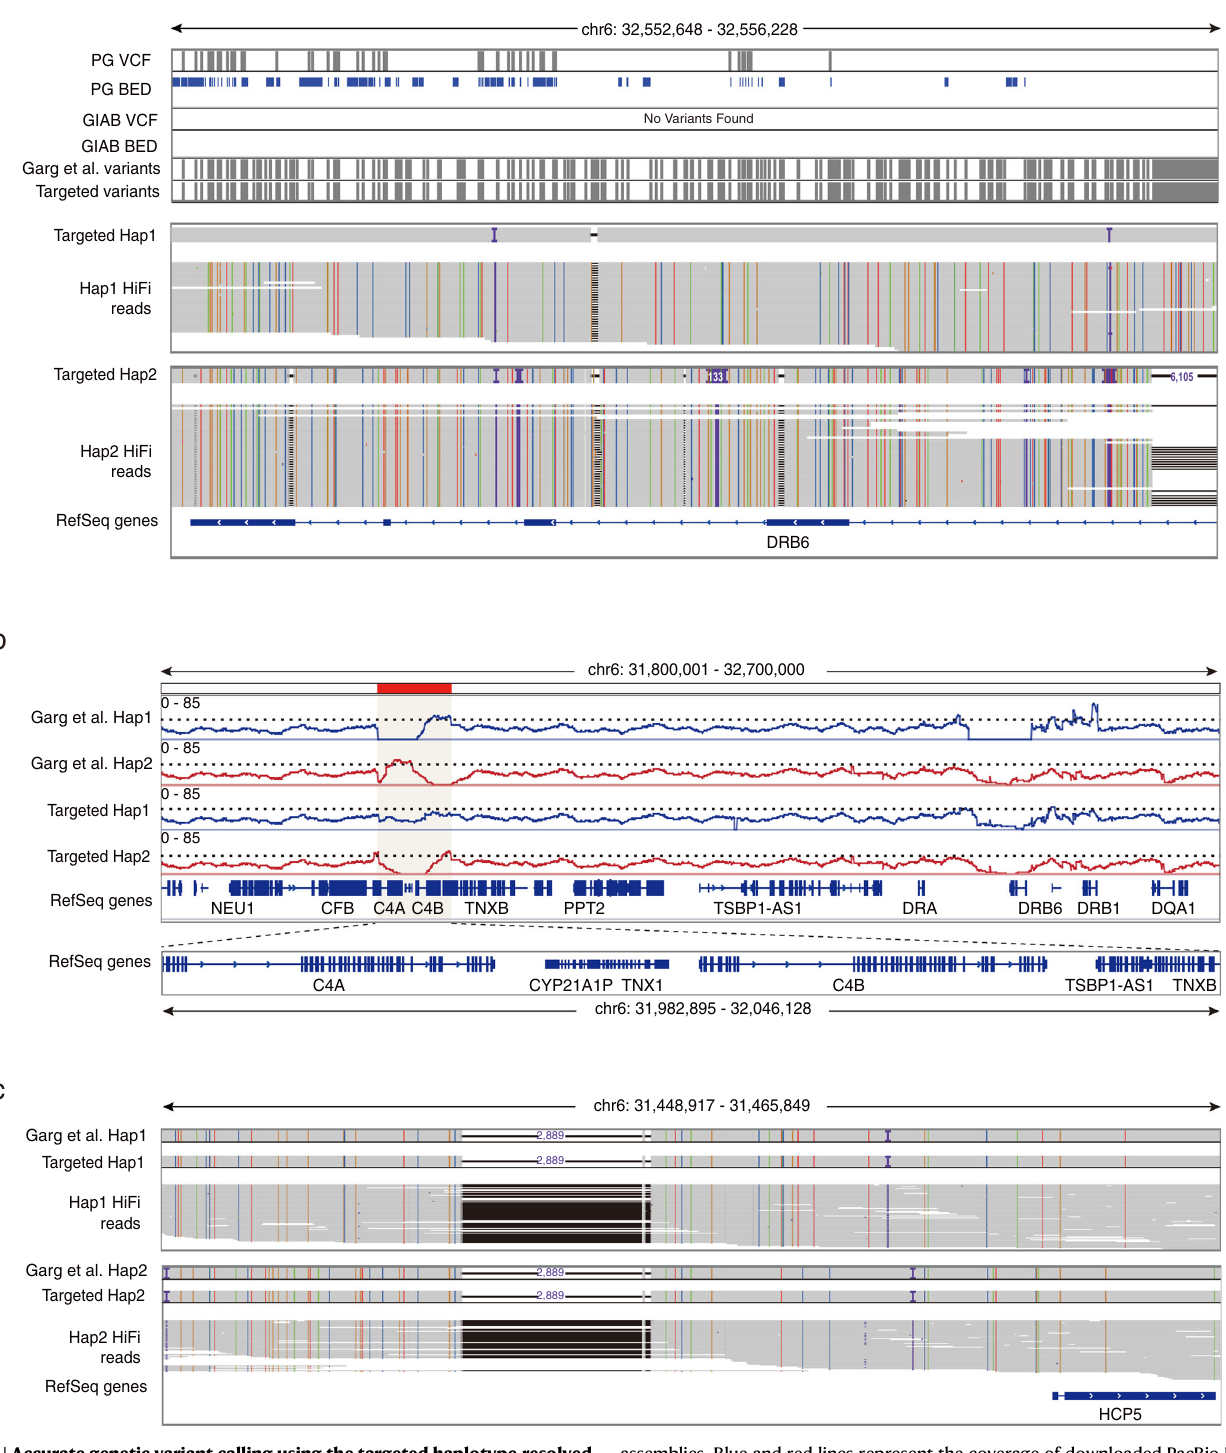
assemblies. Blue and red lines represent the coverage of downloaded PacBio HiFi reads of GM12878 cellsfrom the GIABaligned to the haplotype 1 or haplotype 2 of different assemblies. The dotted lines indicate the threshold of expected coverage (mean+at least three standard deviations) of chromosome 6 excluding the tar- geted MHC region for the collapsed region. The red bar indicates the collapsed region identi fi ed in Supplementary Data 1. c A 2889bp deletion upstream of the HCP5 gene is illustrated and supported by HiFi reads for both